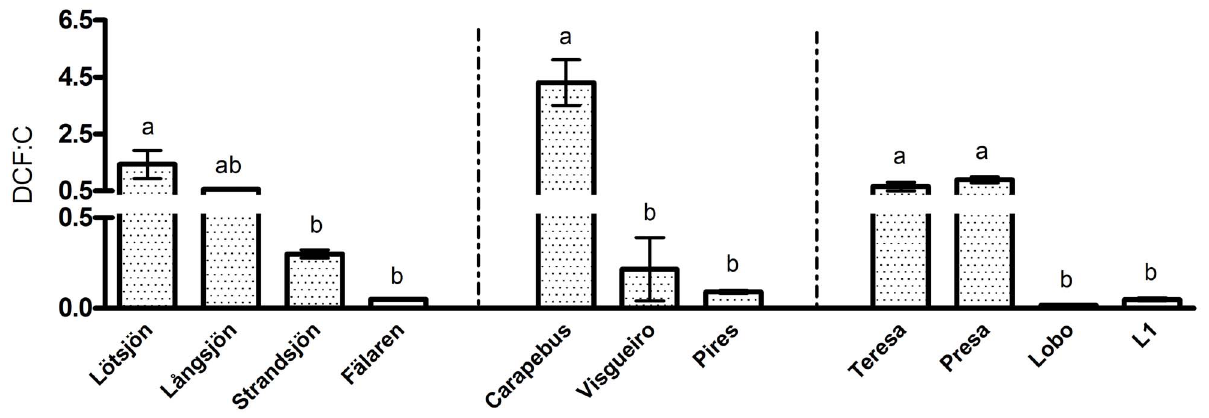
Figure 2. Ratio between dark carbon fixation (DCF; mmol C m 2 2 d 2 1 ) and organic carbon content (C; % of dry weight). DCF:C for studied boreal, coastal tropical and tropical group of lake sediments, respectively. Symbols represent means and bars show SEM (n=5). Different letters indicate significant differences (ANOVA, p , 0.05) between lakes within each group. Note different scales.